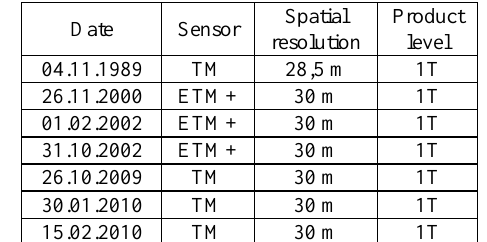
Figure 4. Land use/cover maps